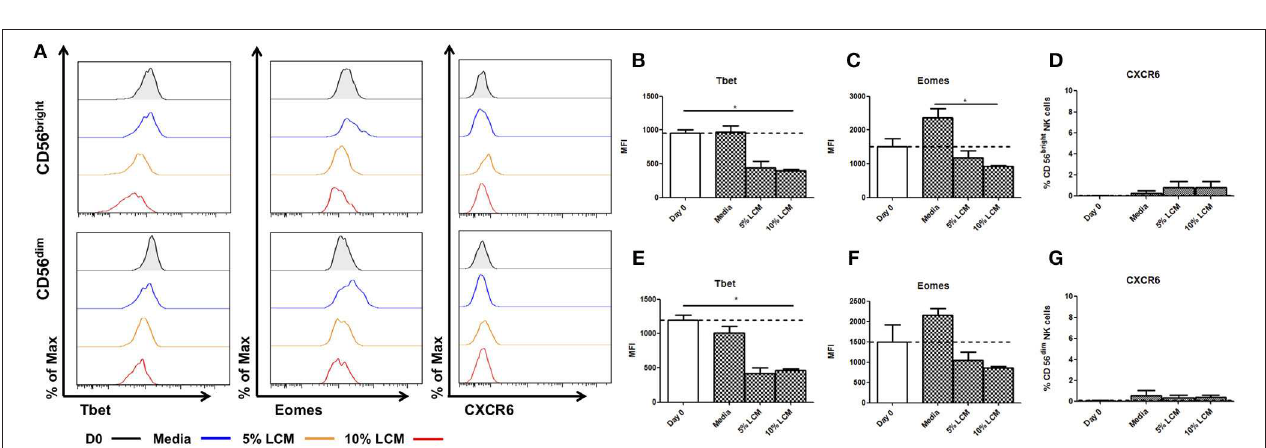
FIGURE 4 | Liver conditioned media suppresses Tbet expression in blood NK cells. NK cells isolated from peripheral blood (PB) were cultured for 7 days, supplemented with 5 or 10% v/v liver conditioned media (LCM) and stained with monoclonal antibodies to assess transcription factor expression. (A) Representative histograms of Tbet, Eomes and CXCR6 expression from cells at day 0 (black line), day 7 untreated (blue line), day 7 5% LCM (orange line), and day 7 10% LCM (red line). (B) MFI of Tbet in CD56 bright NK cells from PB at day 0 and 7 with LCM treatments. (C) MFI of Eomes in CD56 bright NK cells from PB at day 0 and 7 with LCM treatments. (D) Percentage of CXCR6 positive CD56 bright NK cells from PB at day 0 and 7 with LCM treatments. (E) MFI of Tbet in CD56 dim NK cells from PB at day 0 and 7 with LCM treatments. (F) MFI of Eomes in CD56 dim NK cells from PB at day 0 and 7 with LCM treatments. (G) Percentage of CXCR6 positive CD56 dim NK cells from PB at day 0 and 7 with LCM treatments. Data presented as mean ± SEM. Data was analyzed using Friedman test, with Dunn’s multiple comparison test ( n = 5; * p <